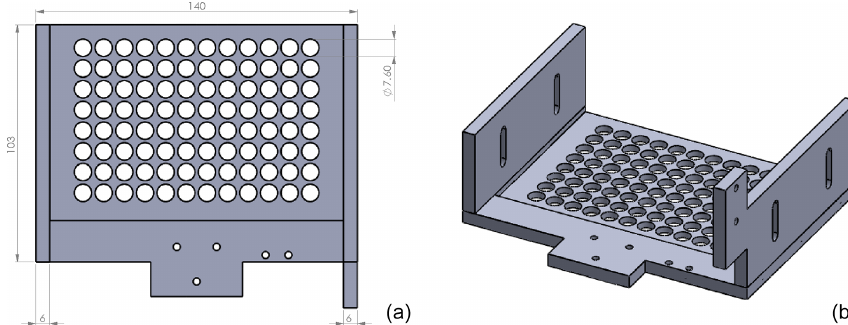
Figure A1. Schematic of the 96-well tray holder from above (a) and the side (b) ; dimensions are in millimeters.